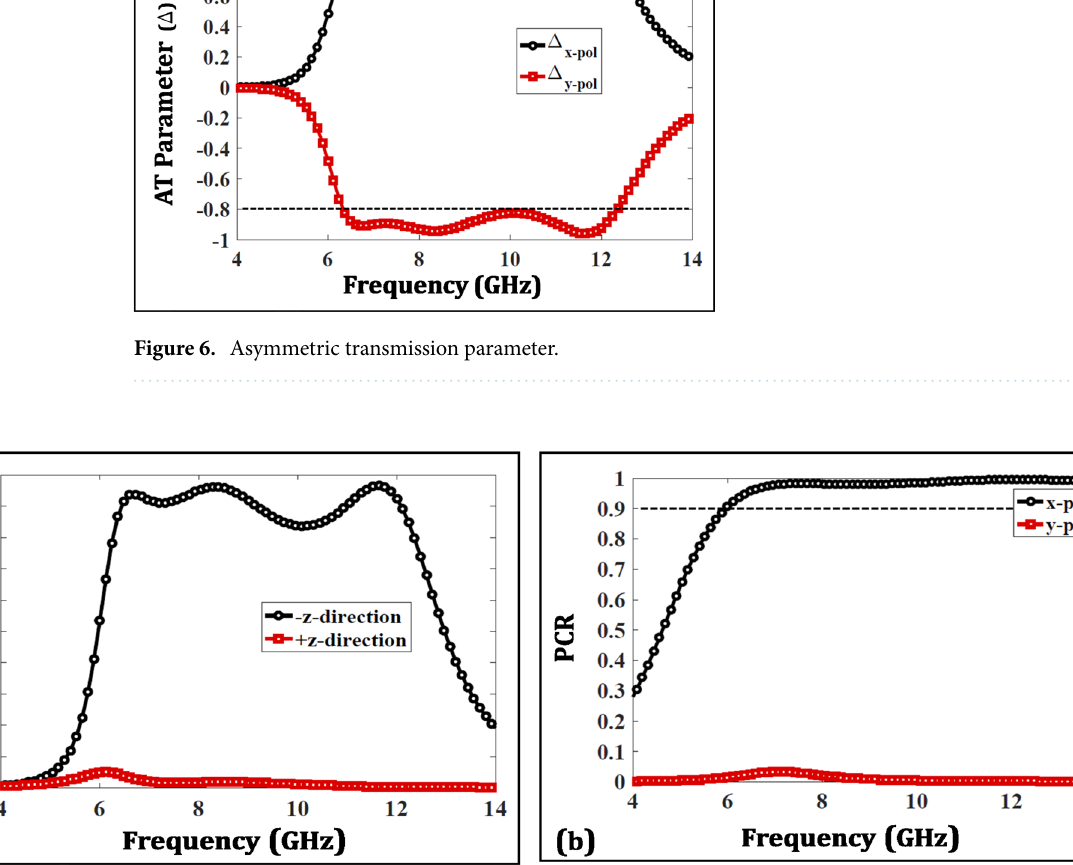
Figure 7. ( a ) Total transmission. ( b ) Polarization conversion ratio